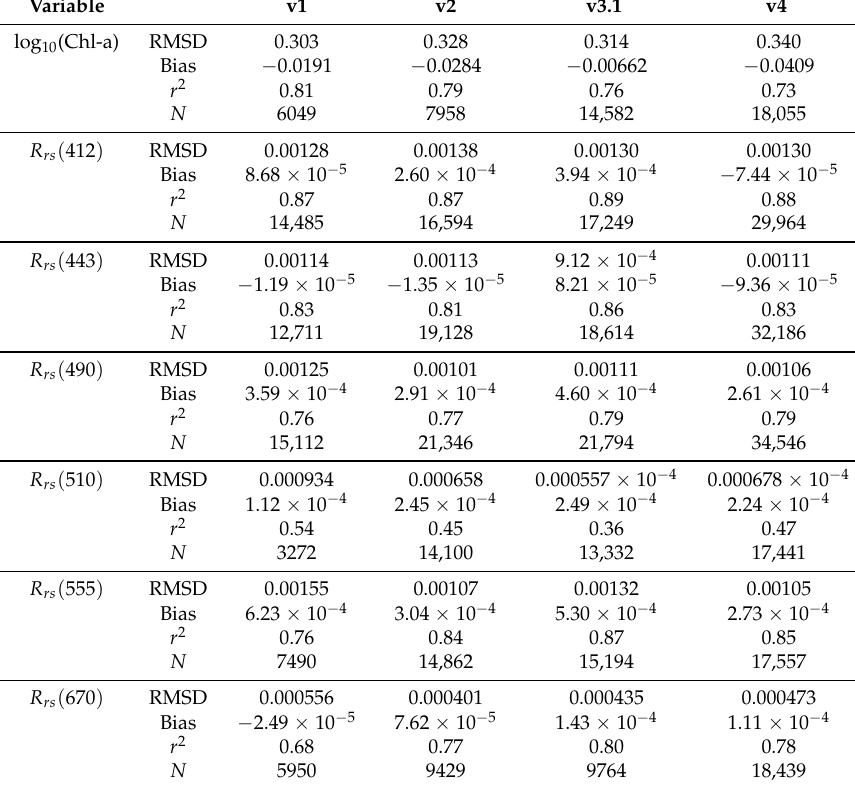
Table 4. Global uncertainty characteristics for oceanic properties derived from OC-CCI merged R rs data for v1 to v4: The results are based on comparison with matched in situ data. Number of match-up observations N that have been used for each of the properties is given. Note that, for chlorophyll-a (Chl-a, in mgm − 3 ), the analyses are done on log -transformed data. The units of R rs are sr − 1 . 10 Variable v1